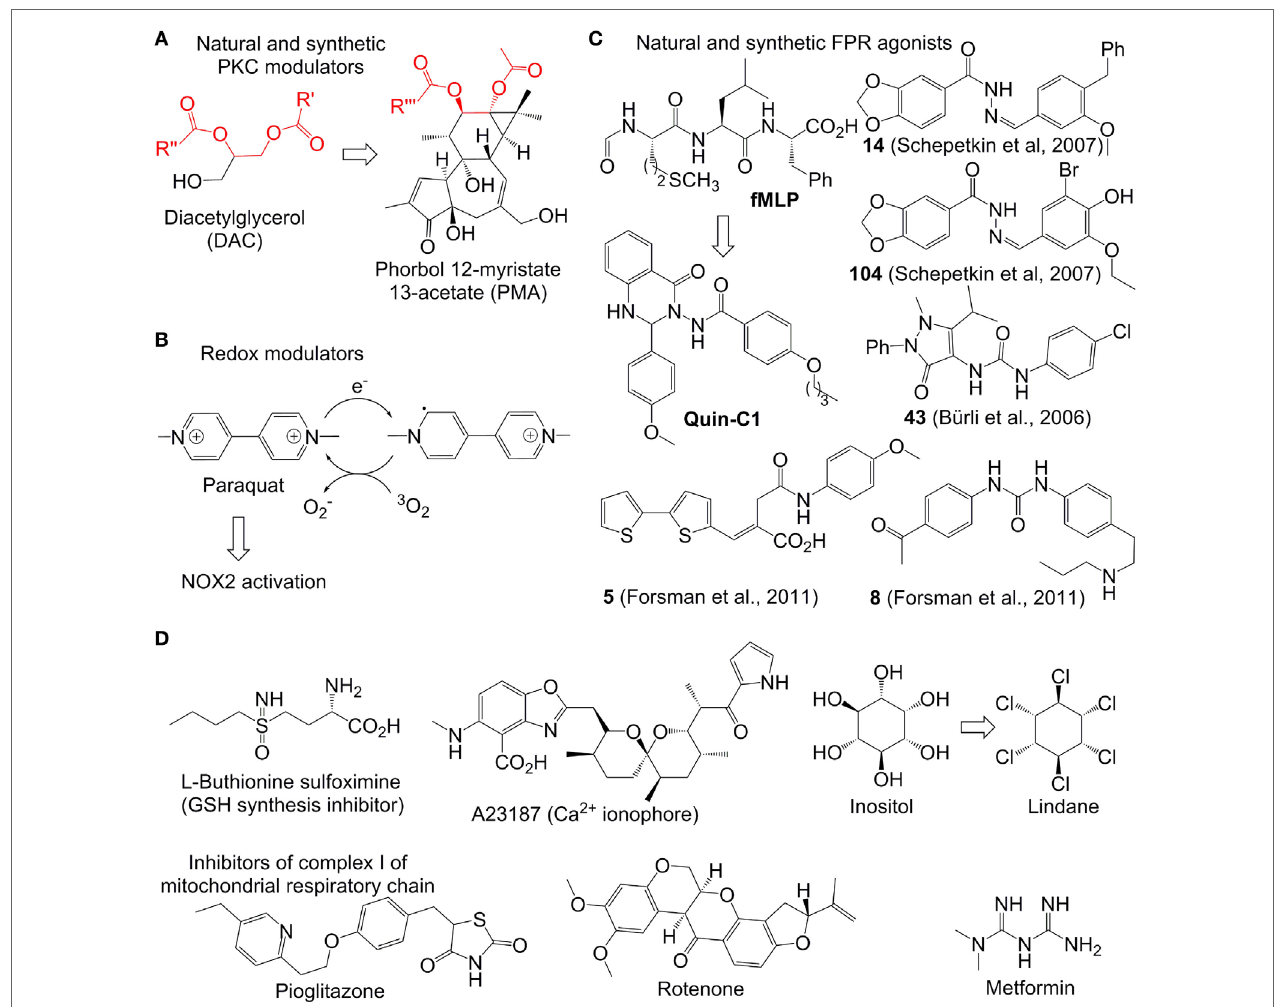
FigURe 3 | Representative reactive oxygen species (ROS) modulators in neutrophils. (A–C) : NADPH oxidase 2(NOX2)-dependent modulators. Quin-C1 is an formyl peptide receptor agonist, but does not induce ROS in cells. (D) NOX2-independent modulators. Structurally related fragments in DAC and phorbol myristate acetate are indicated with red